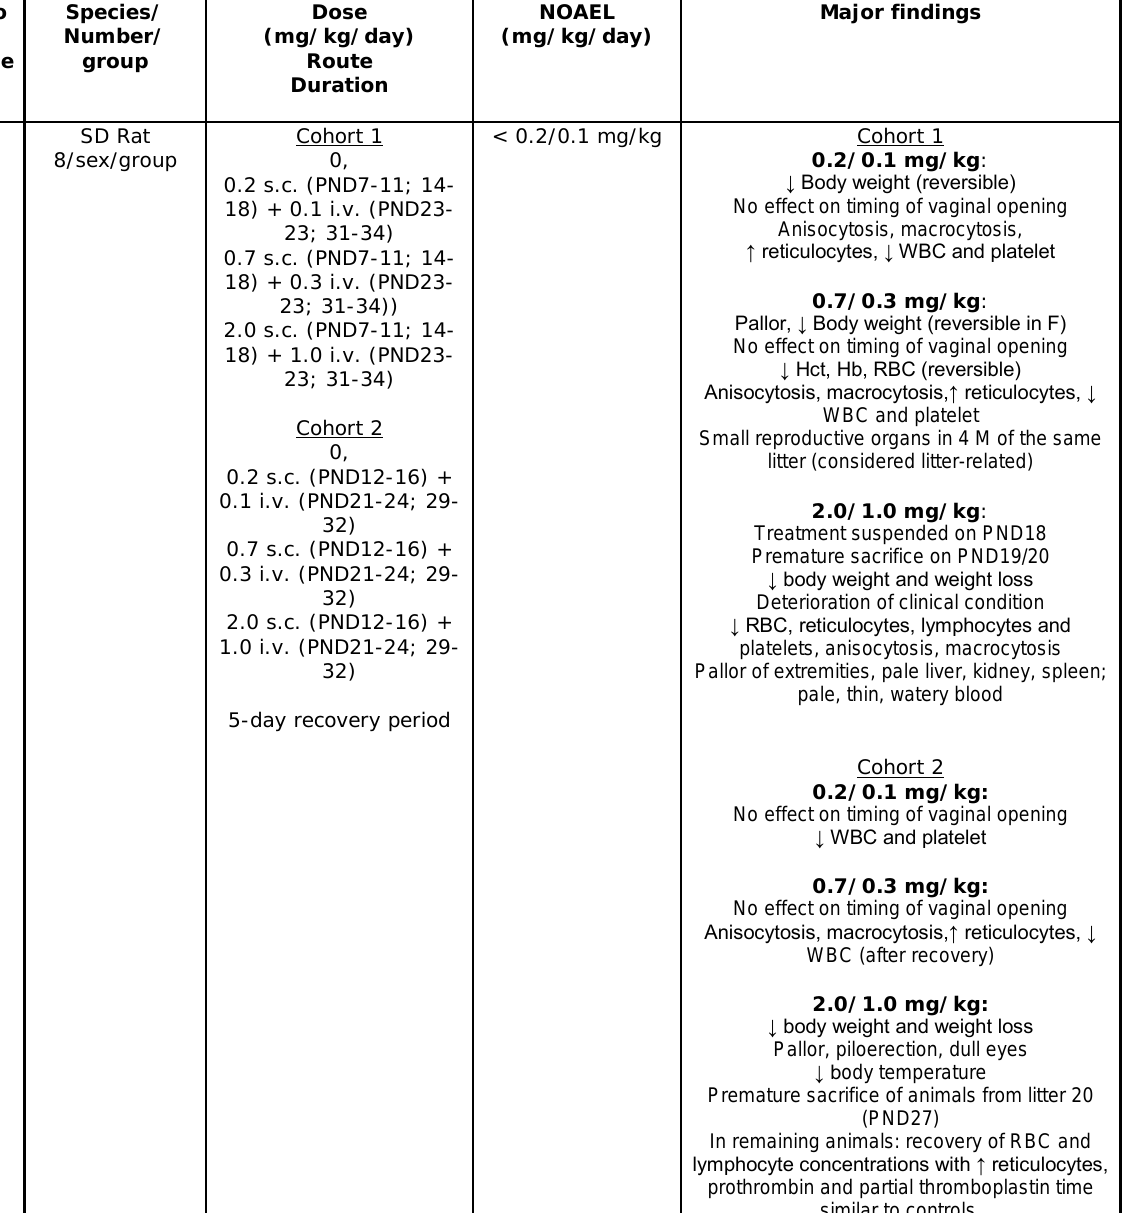
Table 10: Summary of juvenile studies Report No